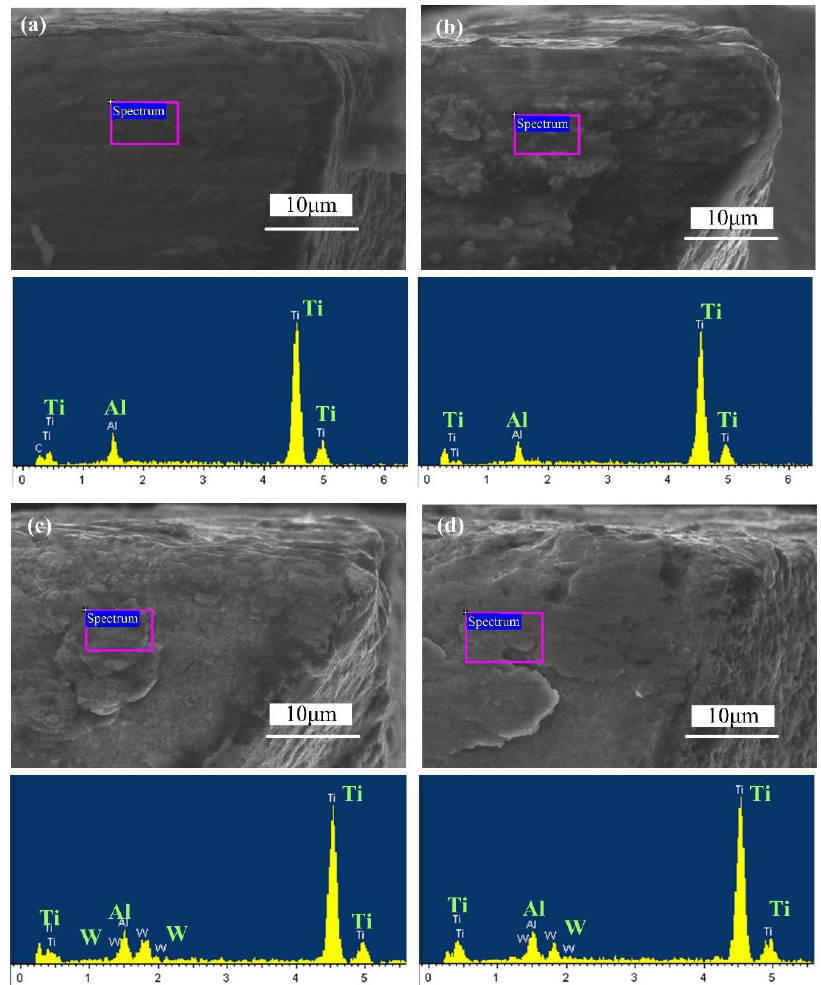
Figure 6. Surface wear morphologies and energy-dispersive spectroscopy (EDS) of differently coated micro end mill flank faces ( v c = 20 m/min, f z = 2 µ m/z, a p = 50 µ m, 640 mm). ( a ) Uncoated micro end mill; ( b ) AlCrN-based coated micro end mill; ( c ) AlTiN-based coated micro end mill; ( d ) TiN coated micro end mill.